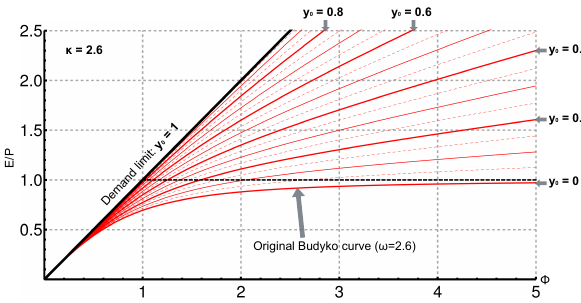
Figure 2. Set of curves of the new framework for κ = 2.6 and dif- ferent y 0 . Note that the obtained curve for the parameter set ( κ , y 0 ) = (2.6, 0) corresponds to the original Budyko curve ( ω = 2.6). The supply limit (dashed black line) is systematically exceeded if y 0 > 0, and the demand limit (solid black line) is reached if y 0 =